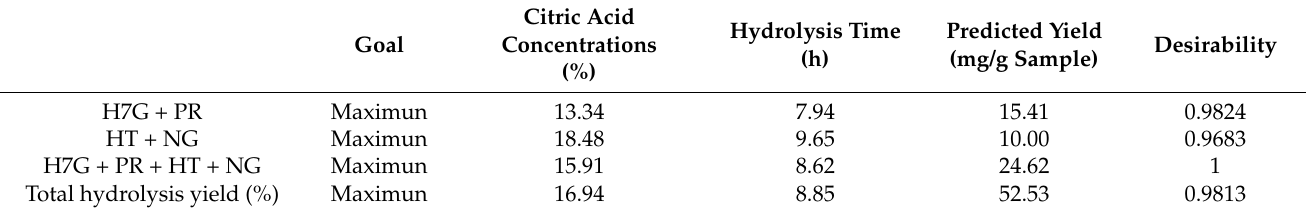
Table 3. Optimized hydrolysis conditions and predicted yields of flavonoid monoglucosides and aglycons.